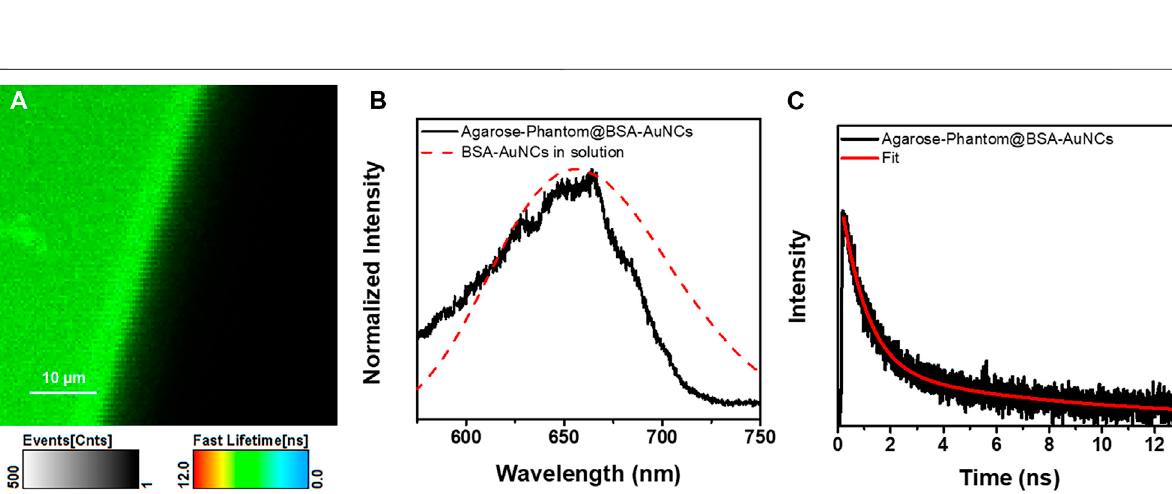
Frontiers in Chemistry |